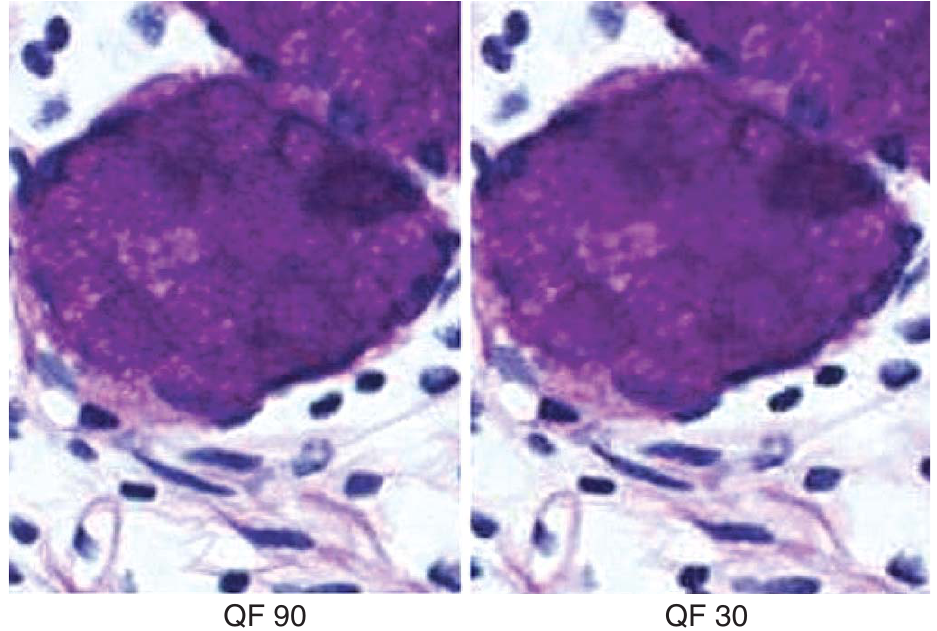
Fig. 3. There is degradation of quality at lower quality but it does not affect diagnosis (periodic Acid Schiff-Diastase stain).